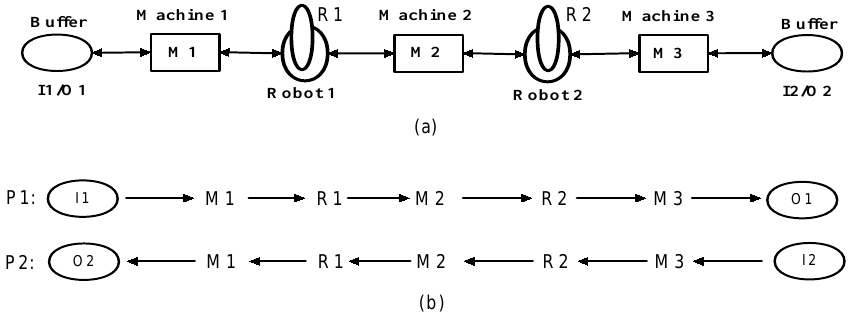
Figure 1. Flexible manufacturing layout.